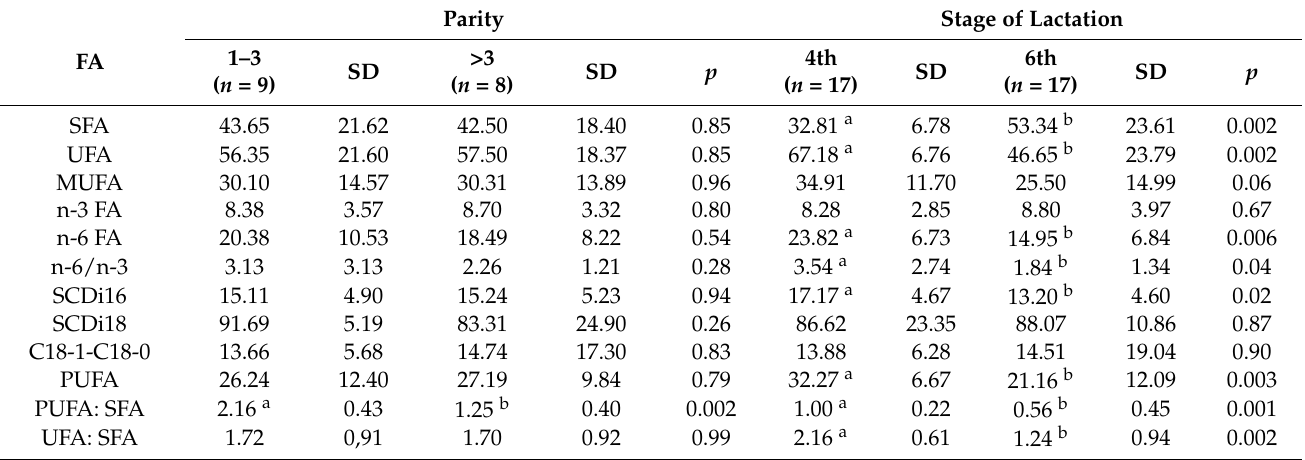
Table 5. LSMs of the composition of healthy fatty acid and ratios between fatty acids in mare’s